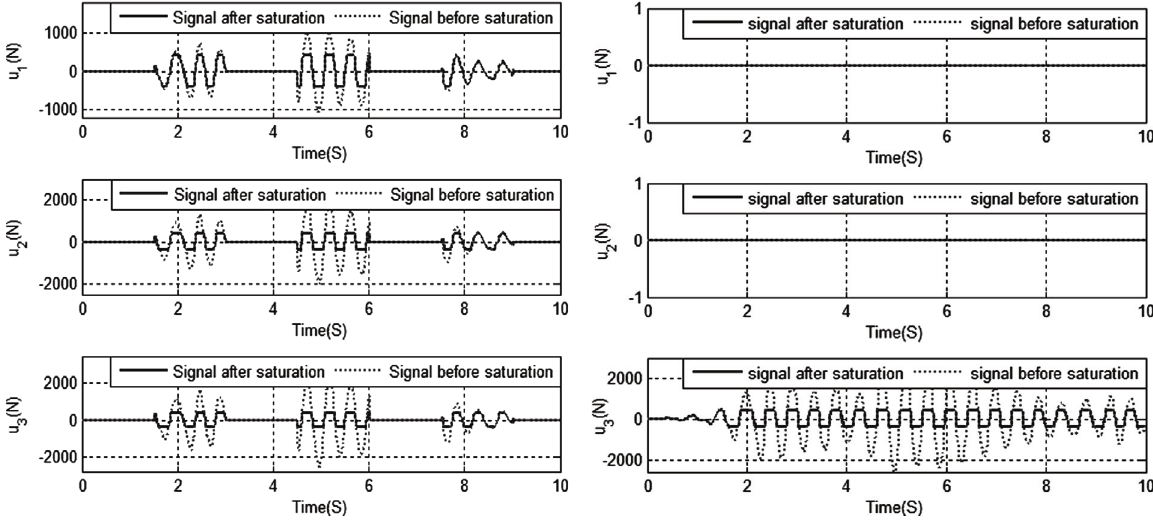
Fig. 8. Control forces in case A3 ( τ = 25 ms). Fig. 9. Control forces in case A4 ( τ = 25 ms).